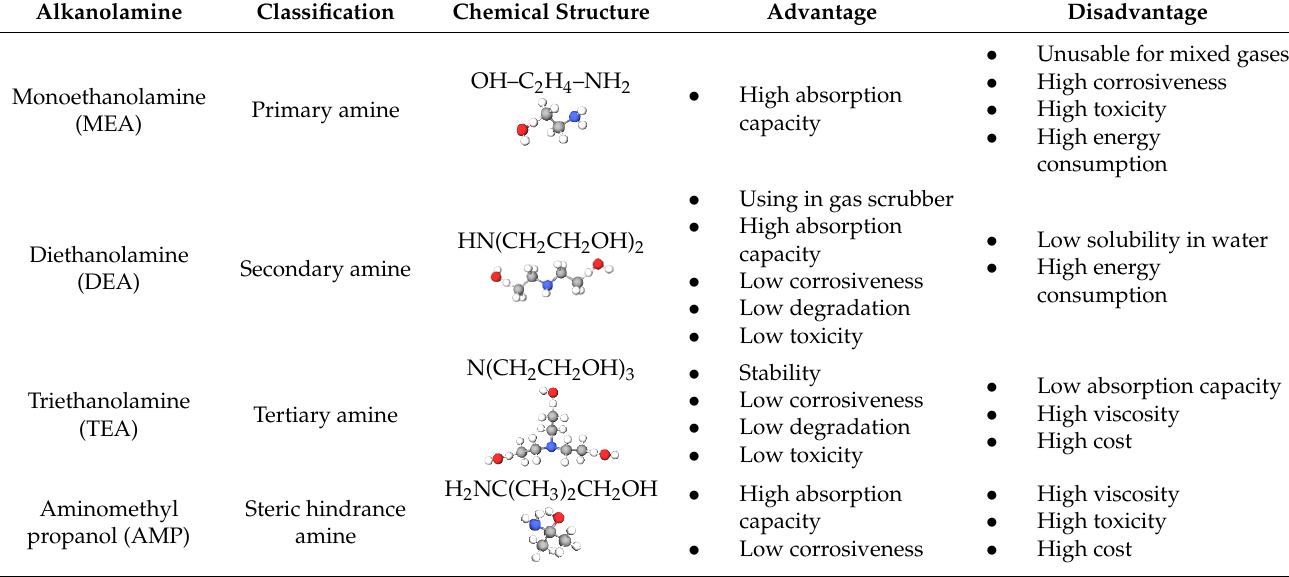
Table 1. Properties of alkanolamine-based absorbents collected data from literature. Vega et al. 2018 [28] identified chemical structure of amines. Chen et al. 2018 [42] summarized limitations of various amines. Smith 1995 [43] created a program of chemical structure of amines. Rinker et al., 1996 [44] explained the advantages and disadvantages of MEA, DEA, and AMP. Liu et al., 2021 [45,46] explained the advantages and disadvantages of TEA.